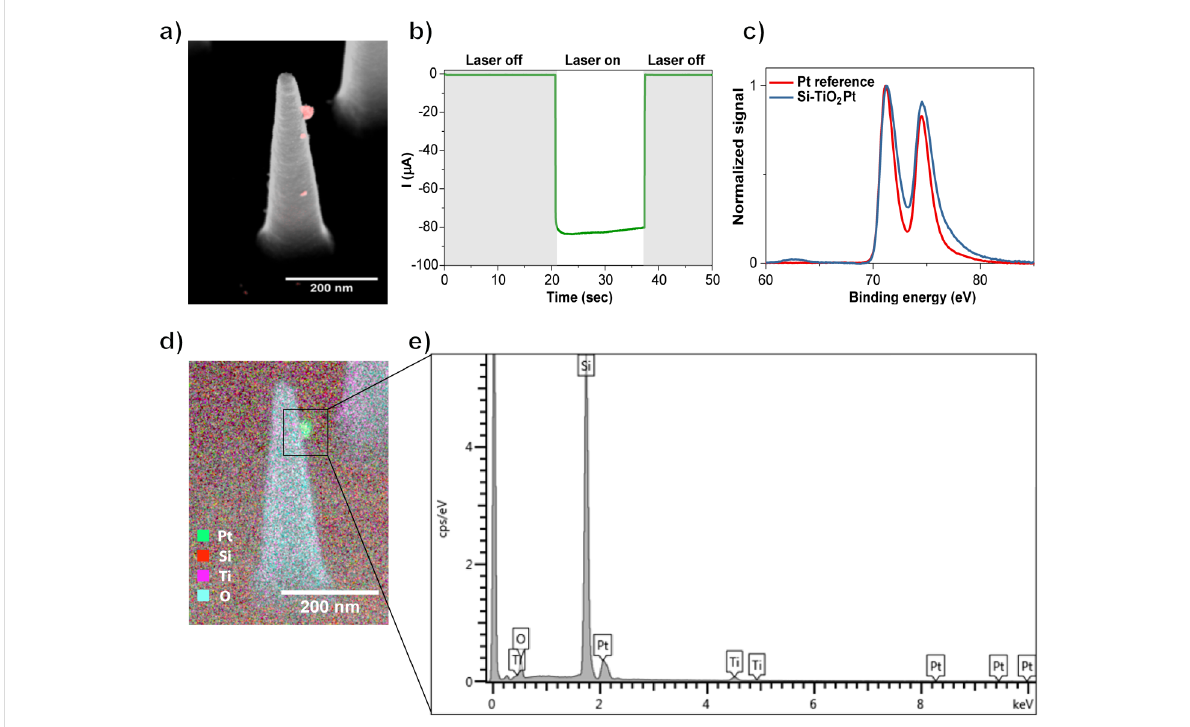
Figure 3: a) An overlay image of a backscattered electron (red; in-lens mirror detector) and secondary electron (grey; through-the-lens detector) SEM image of a silicon nanocone after photo-electrodeposition of platinum. b) Current as a function of the time during a photo-electrodeposition experi- ment of silicon nanocones excited at 532 nm (laser on), at − 0.8 V applied potential in an aqueous solution of H 2 PtCl 6 (pH 11). c) X-ray photoemission spectrum of photo-electrodeposited platinum on silicon nanostructures (blue) compared with the spectrum of a metallic Pt reference material (red). d) EDS elemental map where each color indicates a different element: Pt (green), Si (red), Ti (purple) and O (cyan). e) Elemental map retrieved from an individual deposited particle (100 pA beam current, 10 kV acceleration beam